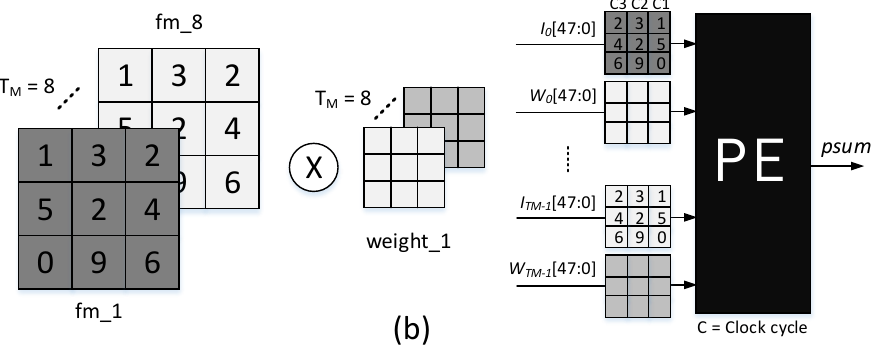
Figure 6. ( a ) Processing element (PE) unit design. ( b ) Processing element data